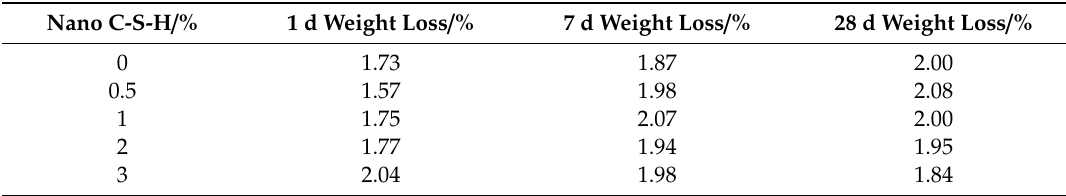
Table 4. The Weight Loss of Ca(OH)2 at Di ff erent